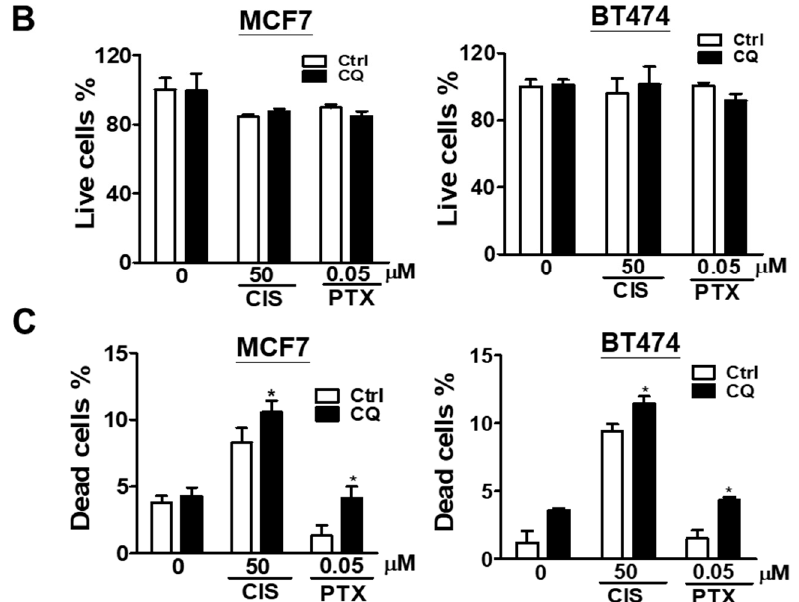
Figure 4. Effects of autophagy inhibition on live/dead cell viability in breast cancer cell lines treating anti-cancer drugs. Breast cancer cell lines pre-treated with autophagy inhibitor CQ (20 µ M) for 5 h were cultured on NanoCulture plates for tumorsphere formation. The tumorsphere was then treated with cisplatin (CIS, 50 μ M) or paclitaxel (PTX, 0.05 μ M) for 24 h. ( A ) The viable (green) and dead (red) cells were assayed using a LIVE/DEAD staining kit and observed by the fluorescence microscopy ( 4 0× magnification). The ( B ) viable and ( C ) dead cells were quantified by a Fluoroskan Ascent FL reader. Results represent the mean of three independent experiments * p < 0.05.